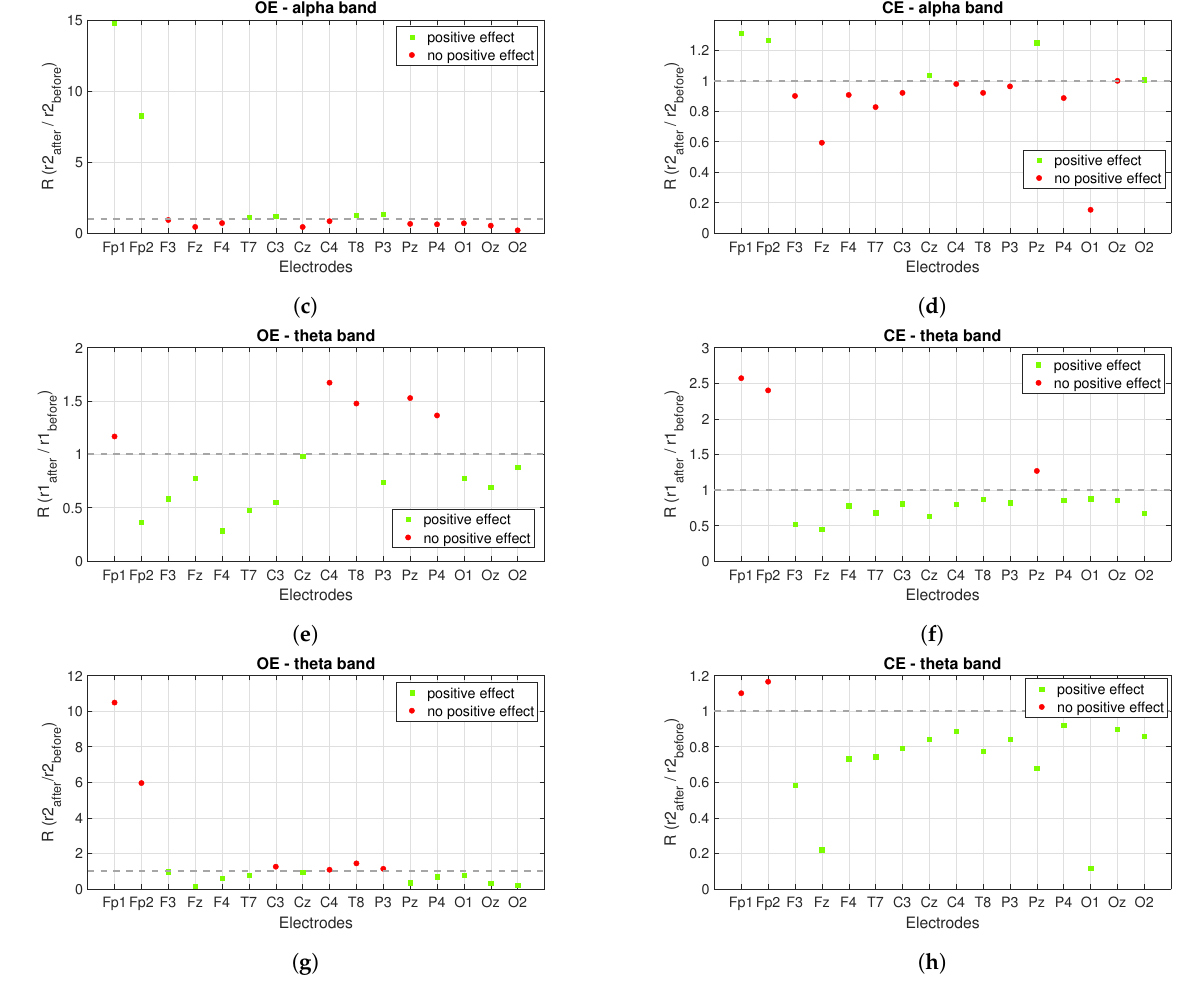
Figure 7. The short-term effect of PBM stimulation on the power spectrum when the alpha and theta bands are observed. The figures show the ratios in the observed bands for the r 1 and r 2: ( a , b ) show the power ratios between the r 1 after and before stimulation for the alpha band with OE and CE for each electrode, ( c , d ) show the ratios for the r 2. ( e , f ) show the power ratios between the r 1 after and before stimulation for the theta band with OE and CE for each electrode. Figure ( g , h ) show the ratios for the r 2 for each